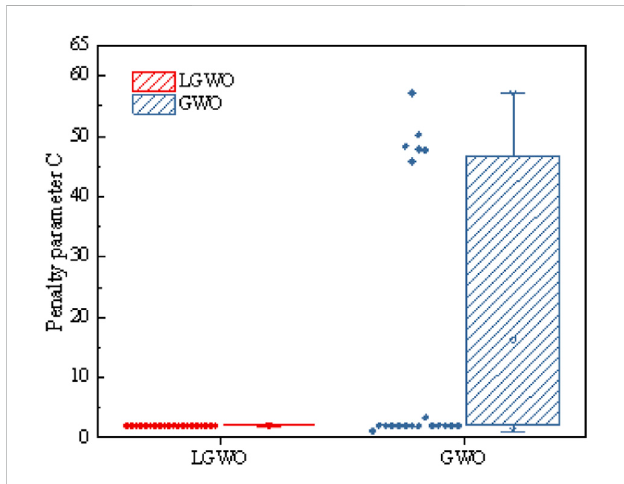
FIGURE 14 The distribution of parameter C for 20 independent runs of the LGWO and GWO algorithms.